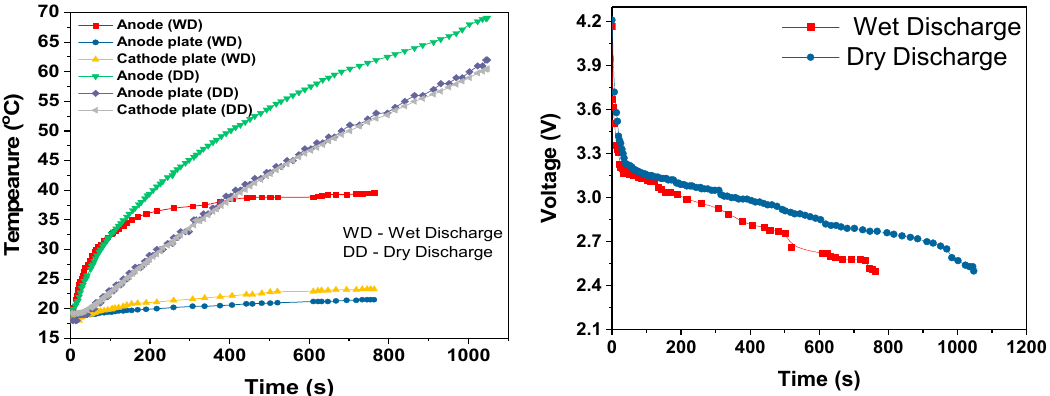
Figure 16. Measured voltage and temperature versus time for the six-cell battery module for the 3C wet and dry discharge rates, measured at various points in the module.